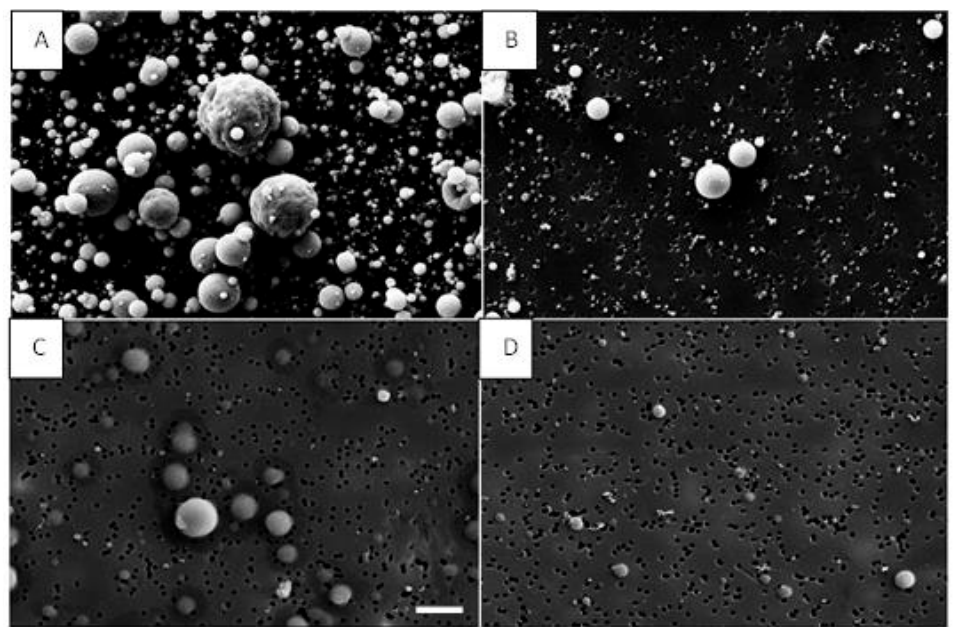
Figure 9. SEM images of particles collected on polycarbonate filters. ( A ) TiO 2 -N particles inside the spray chamber; ( B ) TiO 2 -N at the NF position; ( C ) AgHEC inside the spray chamber; ( D ) AgHEC at NF station. Scale bar (picture C) is 2 µm and all images are in the same scale.